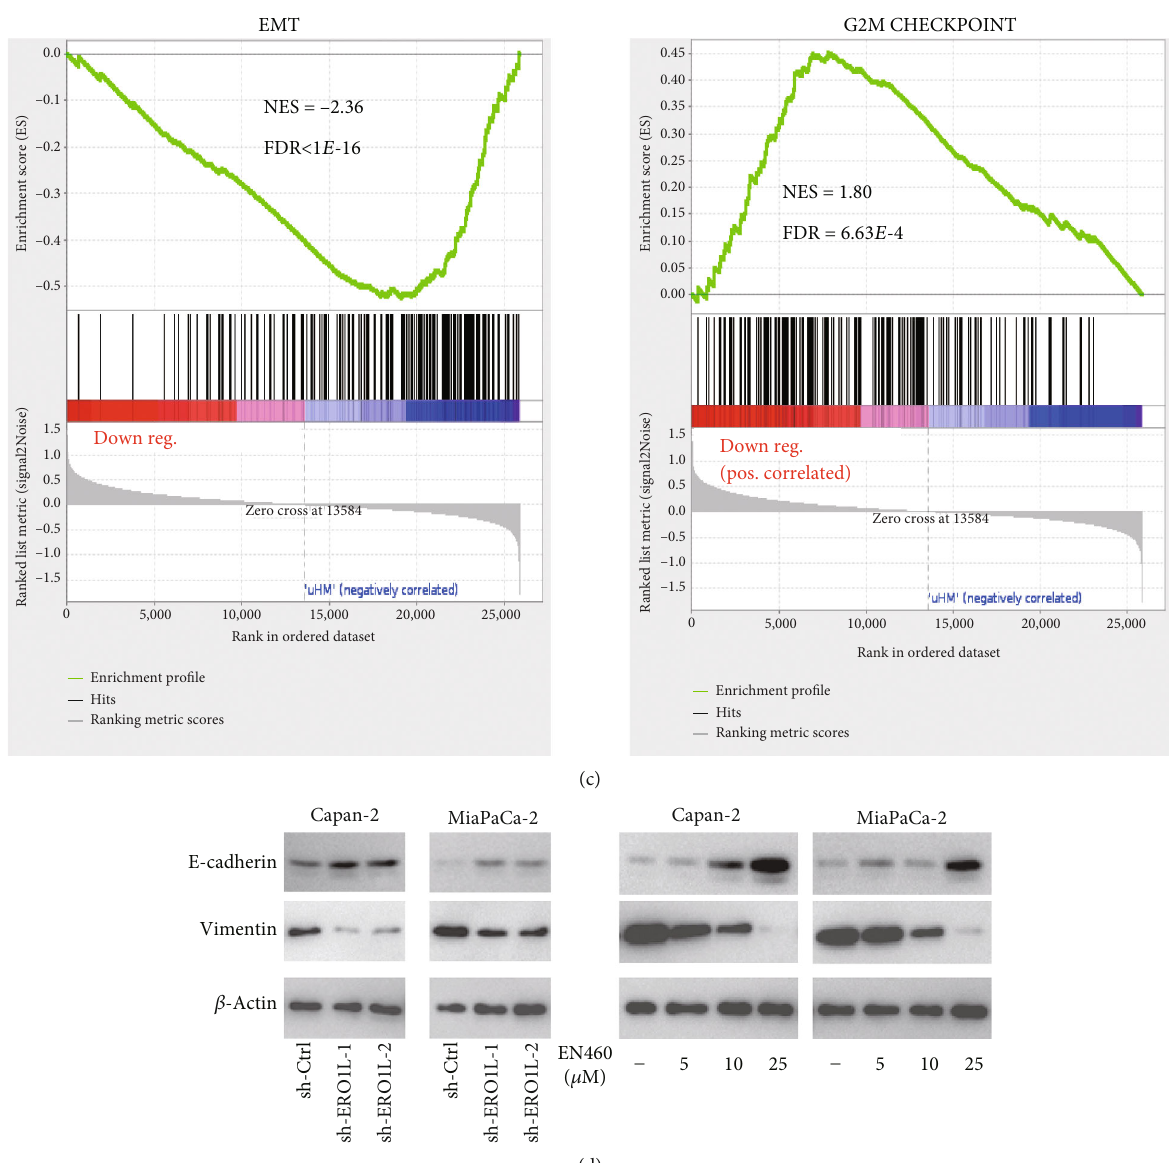
Figure 5: EMT contributes to ERO1L-mediated hepatic metastasis of PDAC. (a) Down reg ( log 2 ð HM/PT Þ < − 0 : 25 ) and otherwise ( log 2 ð HM/PT Þ ≥ − 0 : 25 ) were divided, based on the rate of ERO1L expression in hepatic metastasis and primary tumor. (b) The relatively lower ERO1L expression in hepatic metastasis leading to the lower activity of EMT. (c) GSEA suggesting lower ERO1L expression in hepatic metastasis would remarkably inhibit the activity of EMT pathway and whereas improve the activity of G2M CHECPIONT pathway positively correlated with pancreatic cancer metastasis. (d) Western blotting analysis of Capan-2 and MiaPaCa-2 cells after inhibiting ERO1L expression with shRNAs and